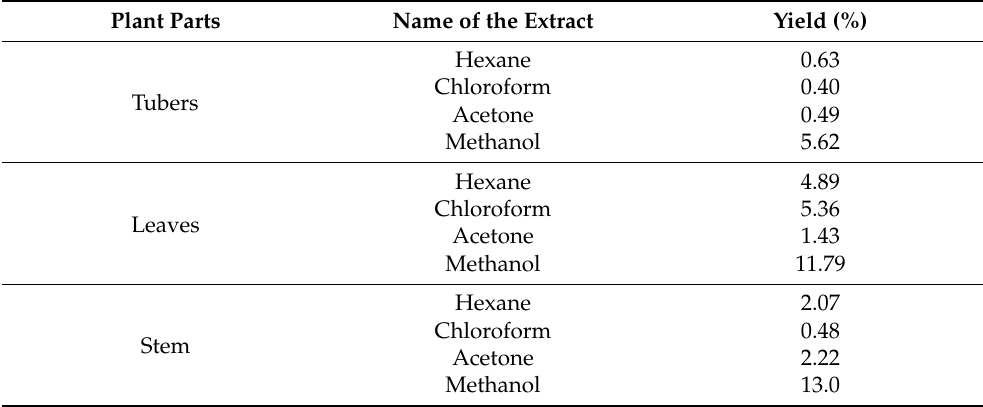
Table 1. Yield of hexane, chloroform, acetone and methanol extracts of M. peregrina. Plant Parts Name of the Extract Yield (%) Hexane 0.63 Chloroform 0.40 Tubers Acetone 0.49